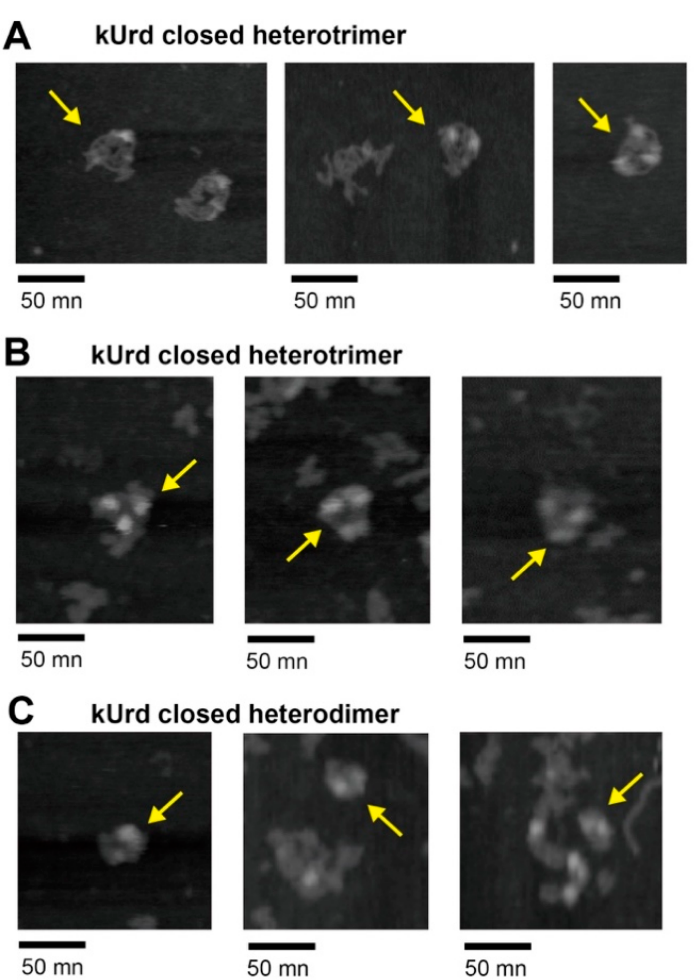
Figure 4. AFM imaging of closed kUrd heterotrimers and closed heterodimers. ( A , B ) AFM of closed kUrd trimers in the presence of 17.5 mM Mg 2+ . Yellow arrows indicate closed kUrd trimers. ( C ) AFM of closed kUrd dimers in the presence of 17.5 mM Mg 2+ . Yellow arrows indicate closed kUrd dimers.